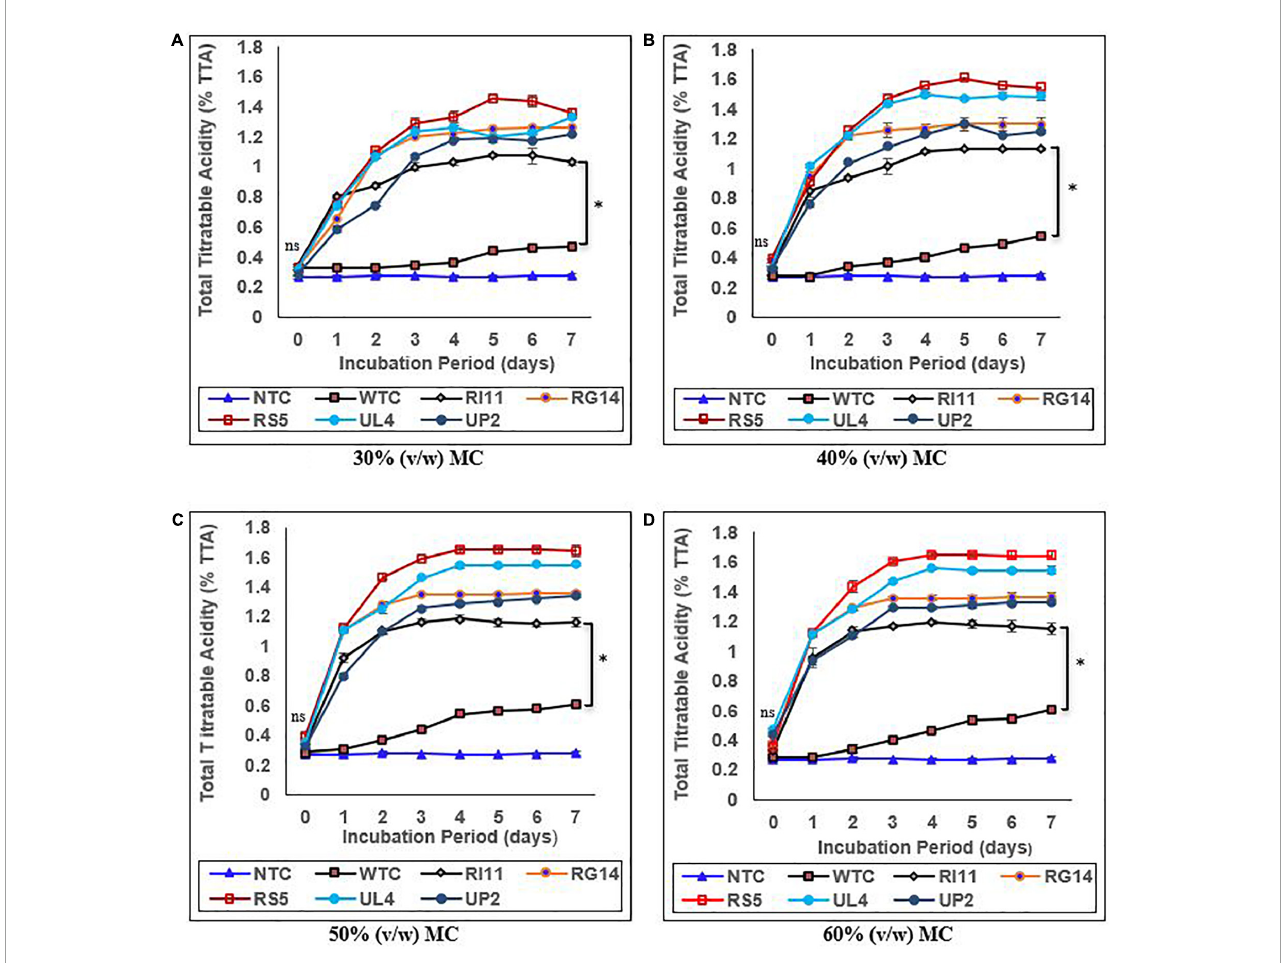
FIGURE2 Effect of moisture contents on the percentage of total titratable acidity of composite flour during 7 days of solid-state fermentation mediated by probiotic strains. Each value represents mean ± SEM, n = 3. NTC, non-treated control; WTC, water-treated control; R111, L. plantarum RI11; RG14, L. plantarum RG14; RS5, L. plantarum RS5; UL4, L. plantarum UL4; UP2, P. pentosaceus UP2. (A) 30% (v/w) moisture content, (B) 40% (v/w) moisture content, (C) 50% (v/w) moisture content, (D) 60% (v/w) moisture content. ∗ Indicate significant difference ( p ≤ 0.05). ns Not significantly